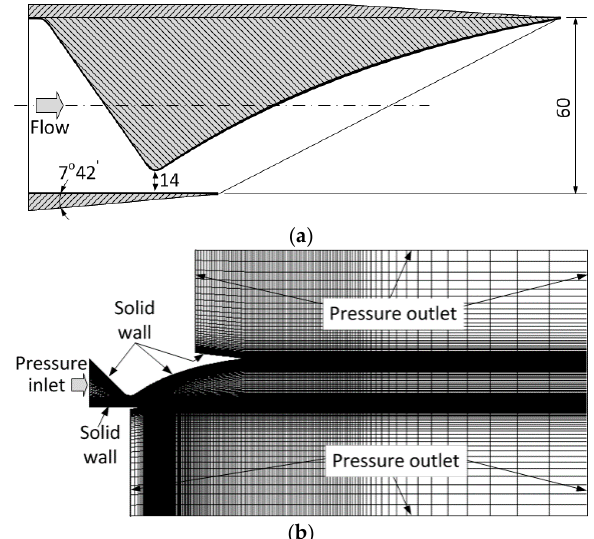
Figure 1. Nozzle geometry and computational grids. ( a ) A geometric details of asymmetric nozzle; and ( b ) the typical mesh and boundary